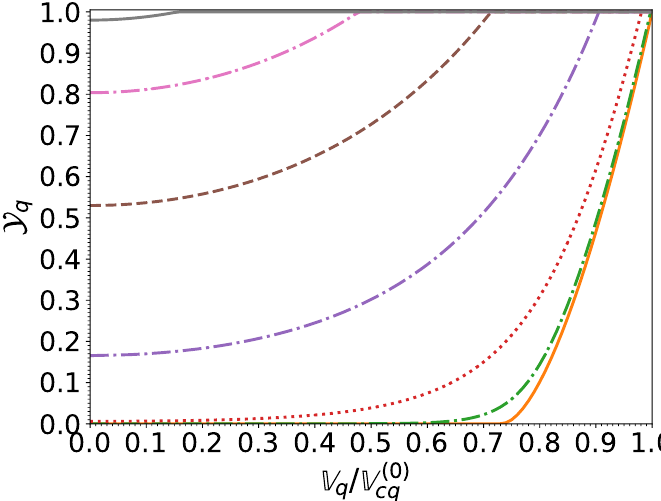
( 0 ) cq for different